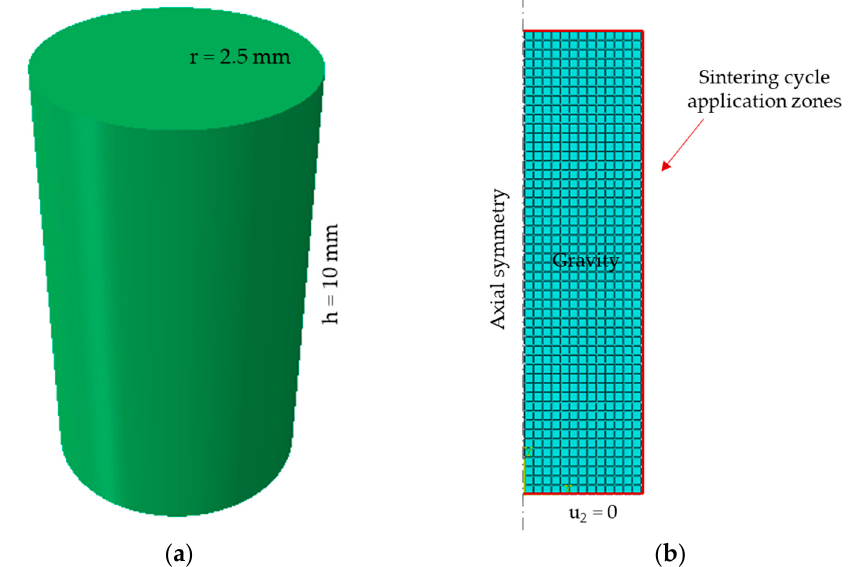
Figure 3. ( a ) Geometry inputted in the FEM software. ( b ) Applied boundary conditions.